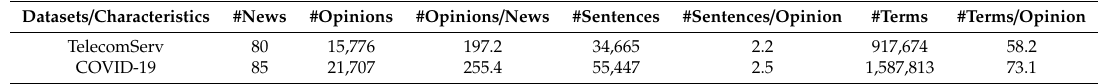
Table 1. Dataset